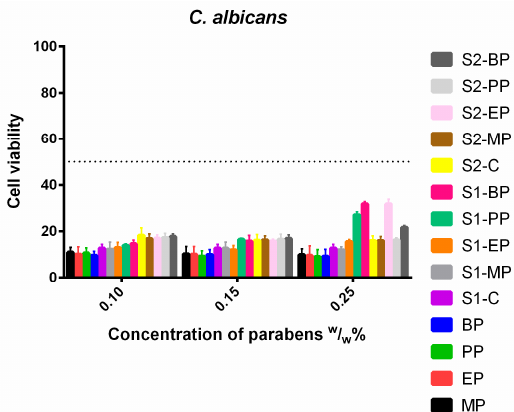
Figure 8. Cell viability of C. albicans against the control paraben solutions (MP; EP; PP; BP); the first system (S1-MP; S1-EP; S1-PP; S1-BP) and the second system (S2-MP; S2-EP; S2-PP; S2-BP). Cell viability expressed as the percentage of the absorbance of the untreated control. Data expressed as mean ± SEM, n = 4. Cell viability of fungal cells at 0.1; 0.15; 0.25 ( w / w )% concentrations of different formulations containing parabens: MP: 11% ± 2.2%; 10% ± 3.2%; 10% ± 2.5%; EP: 10% ± 3.3%; 10% ± 3.4%; 10% ± 4.1%; PP: 11% ± 2.2%; 9% ± 2.3%; 9% ± 3%; BP: 10% ± 1.7%; 10% ± 2.2%; 9% ± 3%; formulated control of S1: 13% ± 1.7%; formulated MP of S1: 12% ± 3.1%; 13% ± 2.7%; 12% ± 1.4%; formulated EP of S1: 12% ± 2.3%; 12% ± 1.9%; 16% ± 0.9%; formulated PP of S1: 14% ± 0.7%; 16% ±